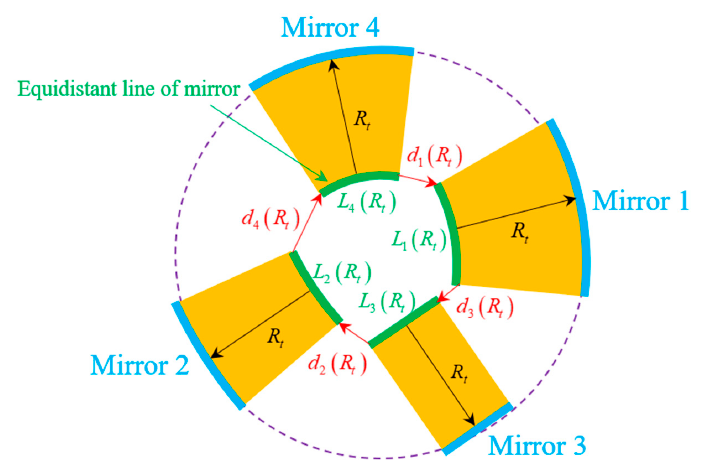
Figure 4. The tool turning radius and tool path in the structure. In the figure, L i ( R t ) is the equidistance lines of the mirror’s surface, d i ( R t ) is the distance between the ends of the equidistant lines of adjacent mirrors and R t is the tool’s radius of gyration.